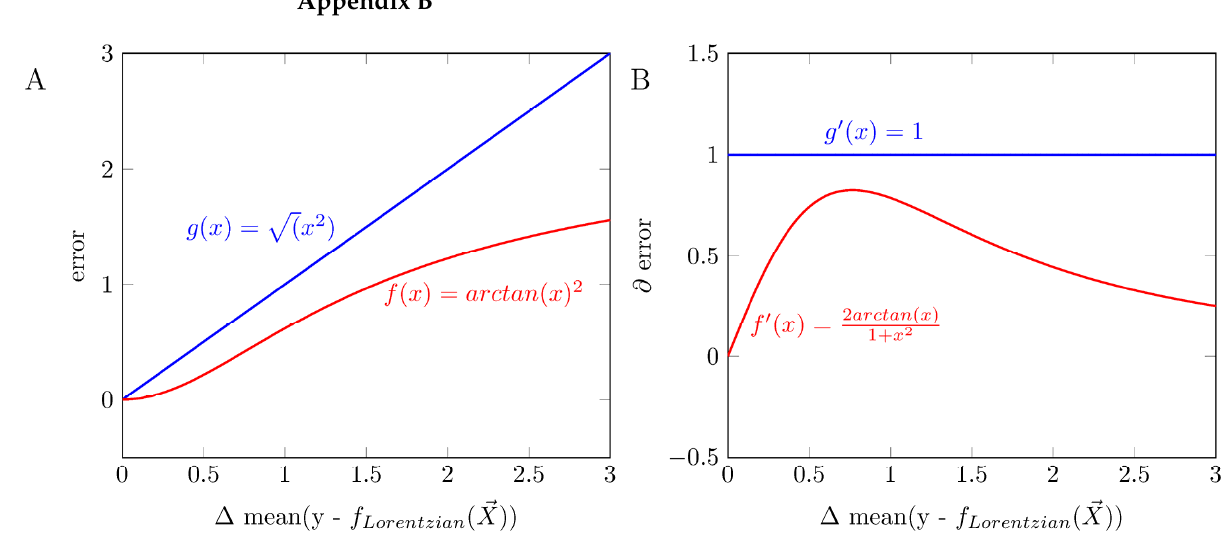
Figure A5. Comparison of arctan as an error function versus the commonly used Root Mean Squared Error (RMSE) function. ( A ) Calculated error as a function of the mean deviation. ( B ) The course of the gradient of the error function as a function of the mean deviation. Here, the arctan shows an adaptive adjustment of the error gradient, which is especially advantageous for optimizing many hyperparameters.